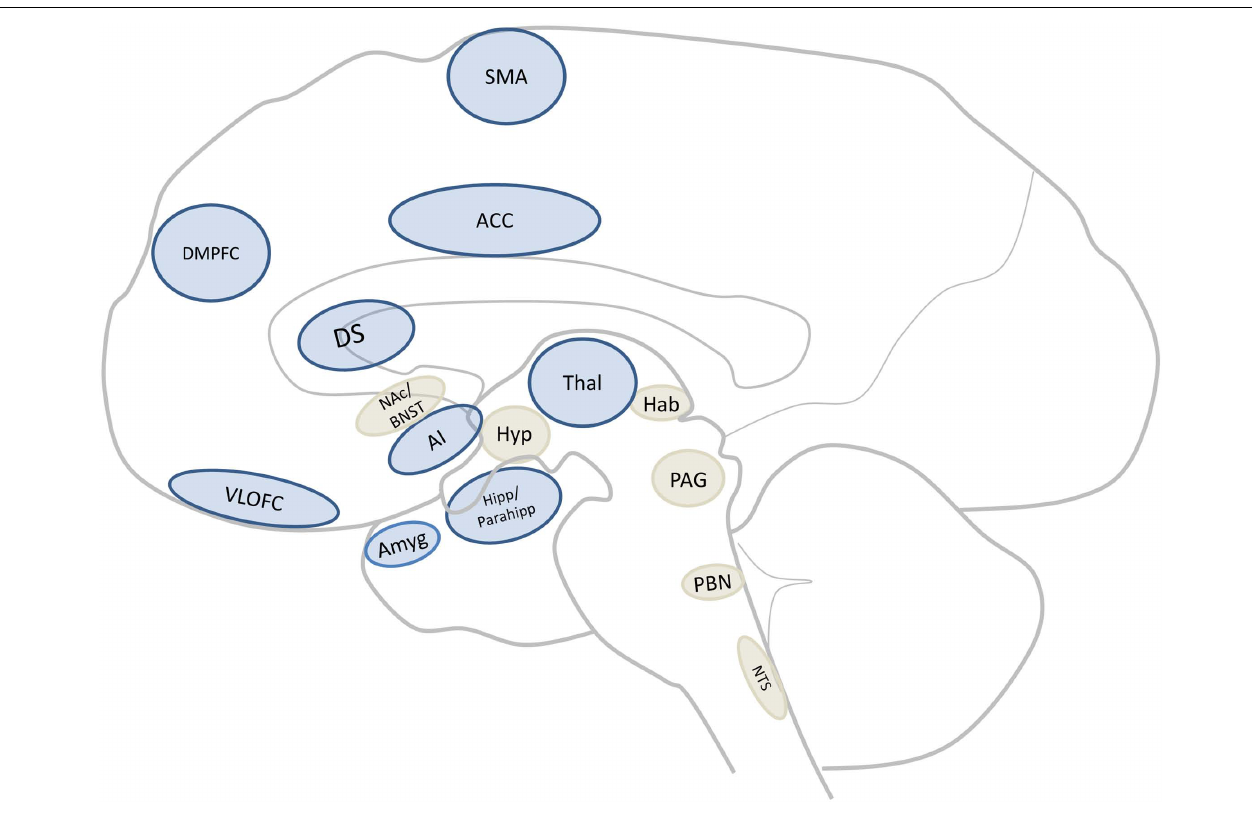
areas across mammals. Abbreviation: BNST, bed nucleus of the stria terminalis; Hab, habenula; Hyp, hypothalamus; NAc, nucleus accumbens; NTS, nucleus of the tractus solitarius; PAG, periaqueductal gray; PBN, parabrachial